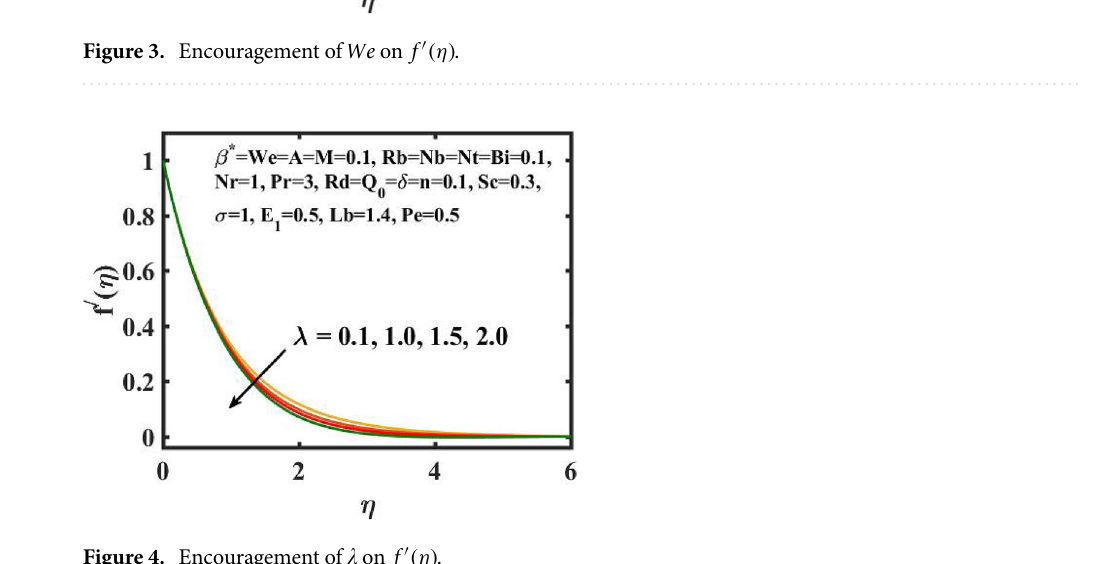
Figure 4. Encouragement of (cid:31) on f ′ (η) .